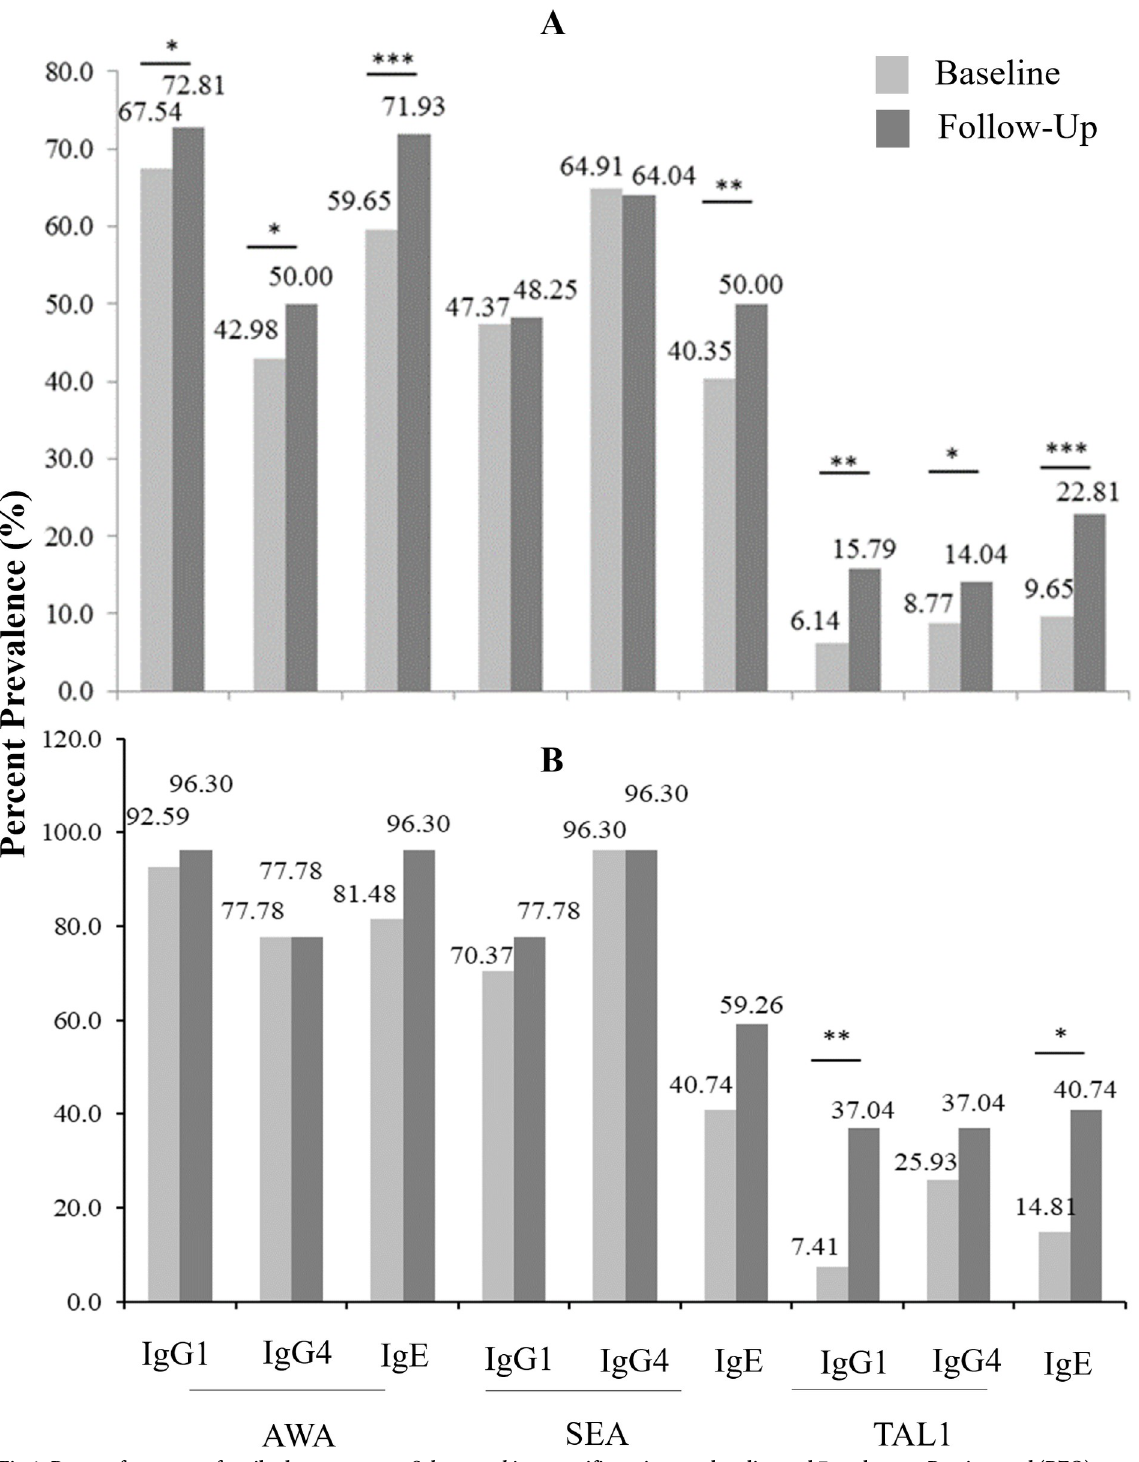
Fig 4. Percent frequency of antibody responses to S . haematobium -specific antigens at baseline and 7 weeks post-Praziquantel (PZQ) treatment. (A) Overall percent frequency of positive antibody responders to the S . haematobium antigens under scrutiny both at baseline and follow-up. (B) Percent frequency of positive antibody responses among treated S. haematobium -infected participants (N = 26) to S . haem a tobium antigens under scrutiny both at baseline and follow-up. The Related Samples McNemar Test was employed in determining p- values. � is indicative of p-values < 0.05, whilst �� is indicative of p-values < 0.01, and ��� is indicative of p-values < 0.001. ShTAL1 = S .